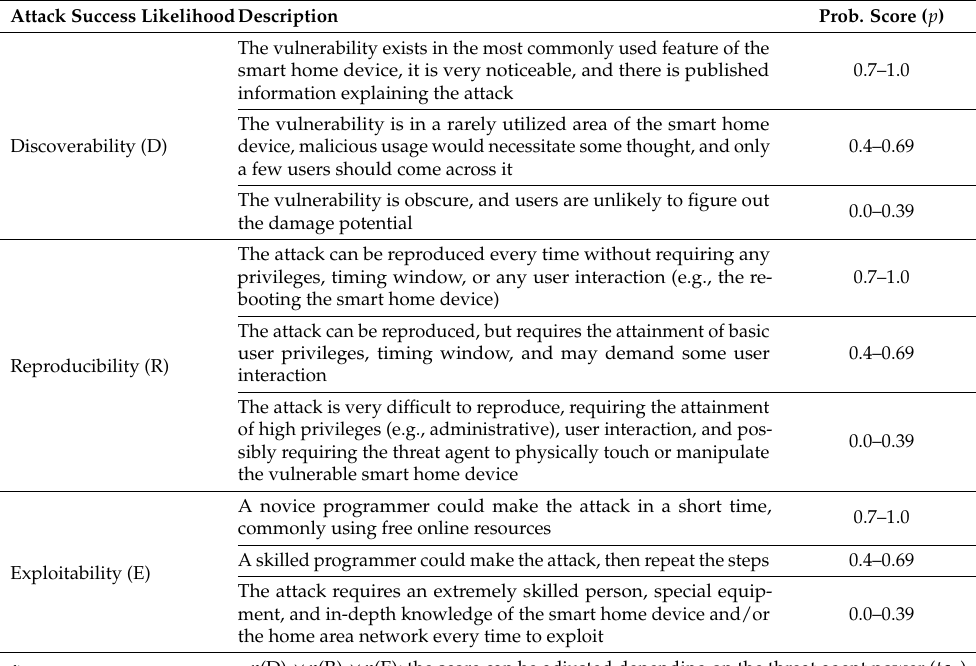
Table 4. Guidelines for grading the attack success likelihood ( α l